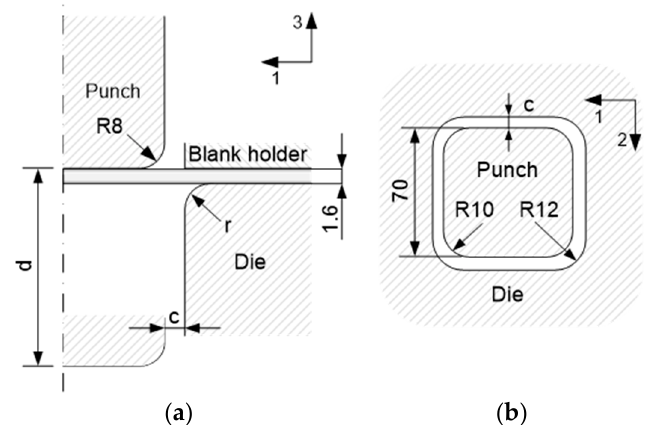
Figure 3. Schematic representation of the geometry of the numerical deep drawing setup for the U-channel and the square cup (dimensions in mm), data from [16,18]: ( a ) longitudinal sectional view of both processes, ( b ) top view of the square cup tooling.